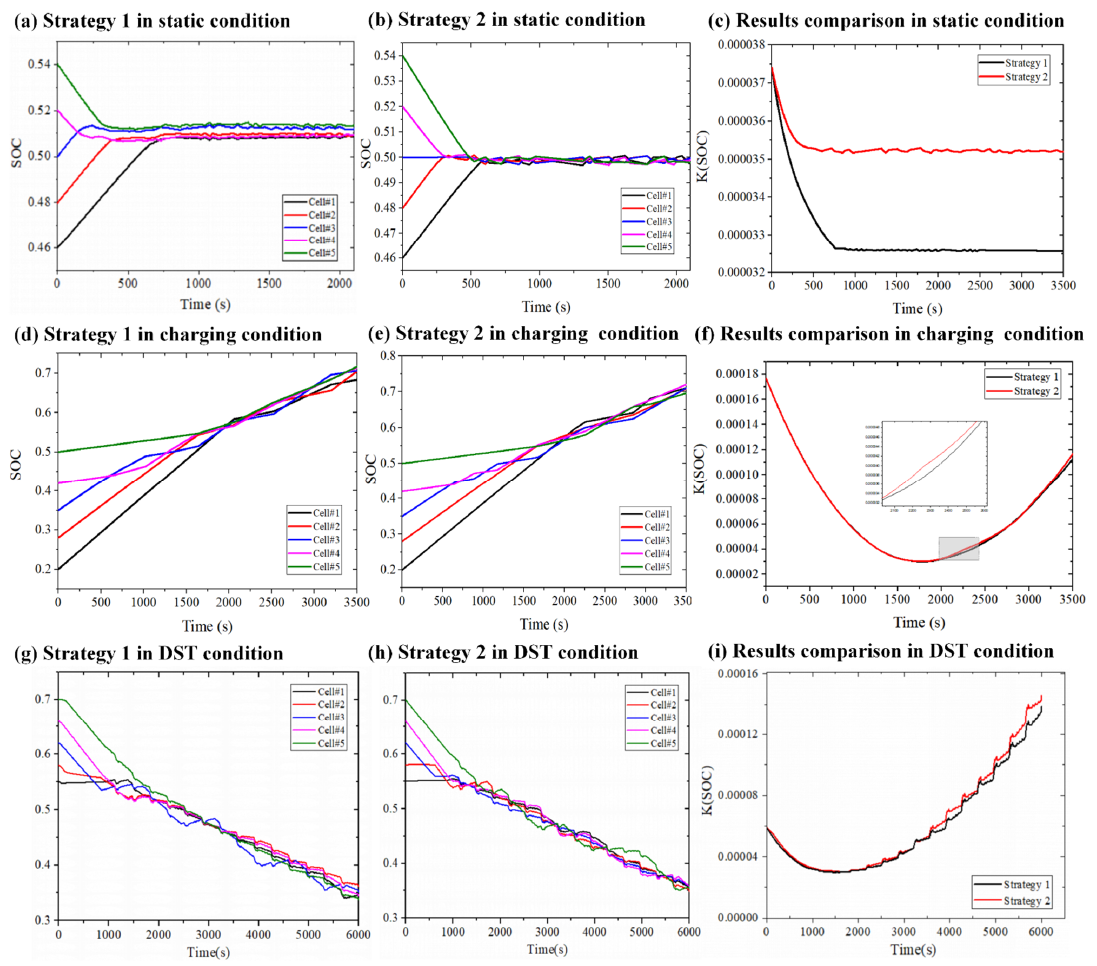
Figure 4. Simulation results .